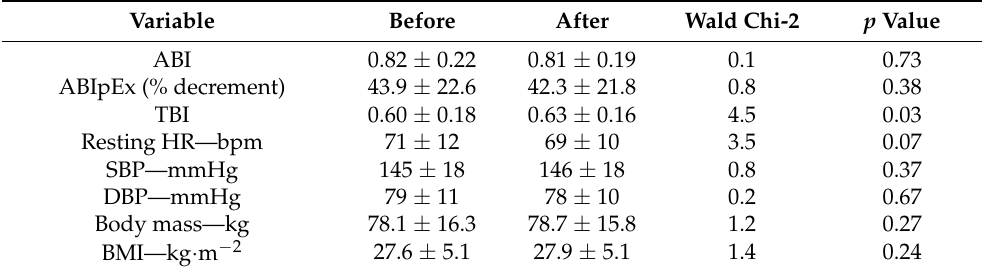
Table 6. Vascular parameters and physical characteristics before and after supervised exercise training.